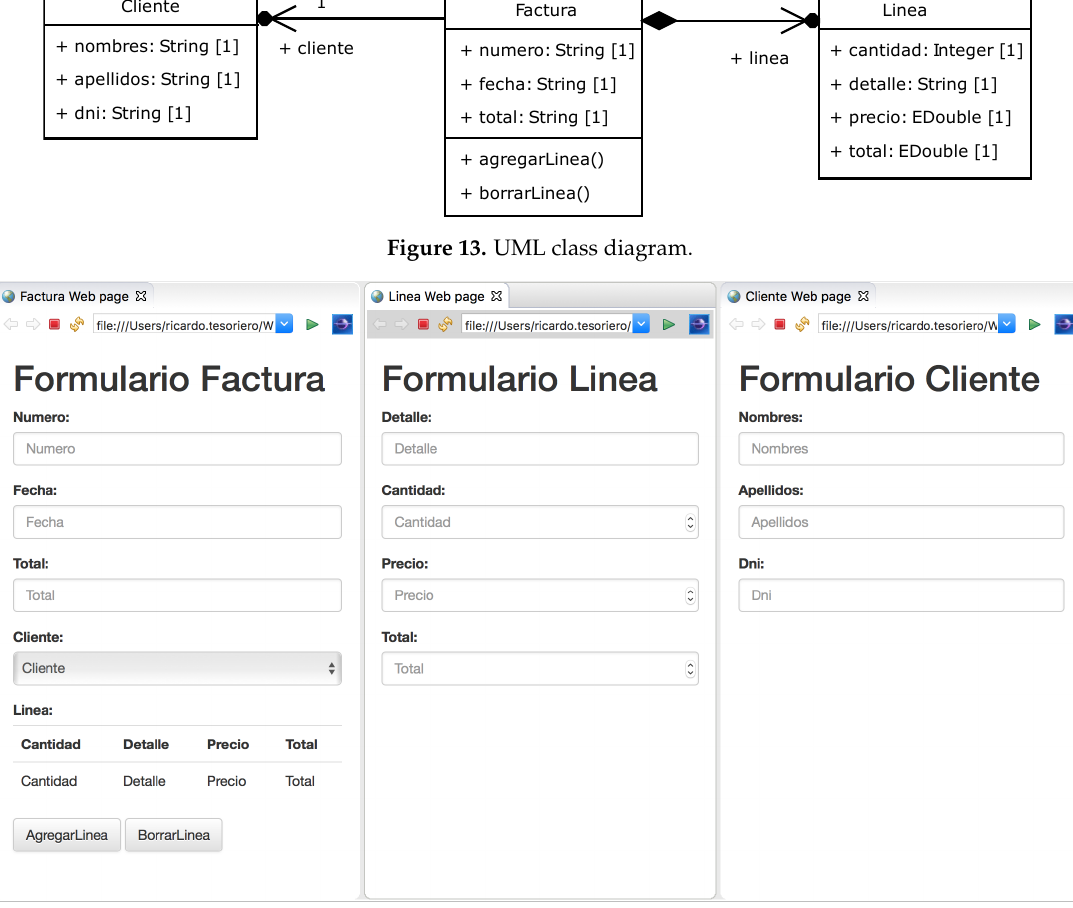
Figure 14. XHTML generated